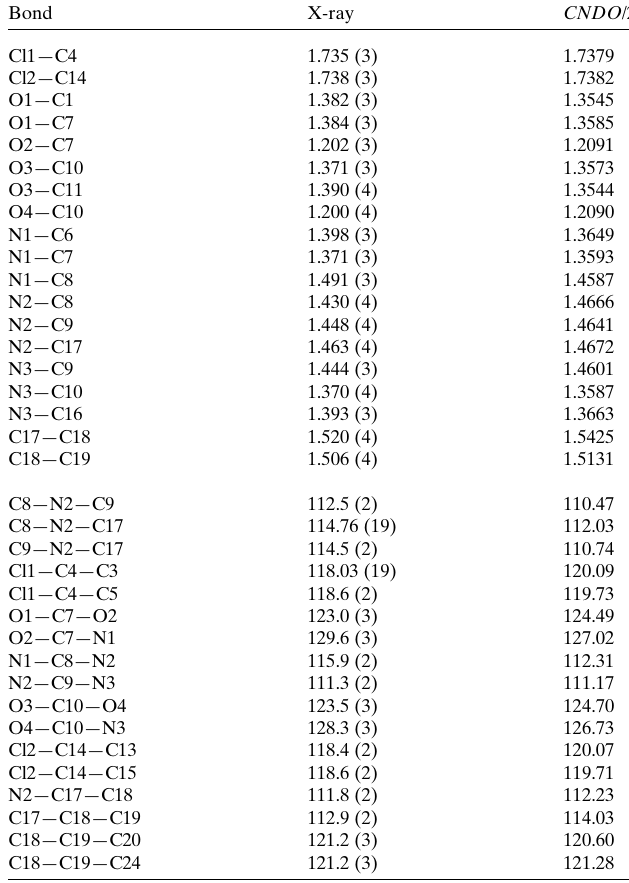
Table 1 Comparison of experimental (X-ray) and theoretical ( CNDO /2) bond lenghts and angles (A˚ , (cid:2) ) for the title compound.